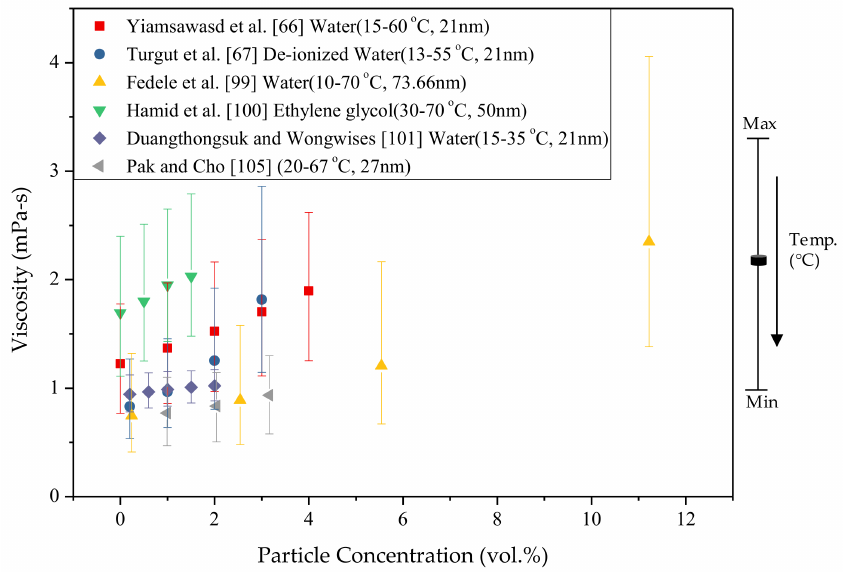
Figure 19. Viscosity of TiO 2 nanofluid as a function of nanoparticle concentration (various